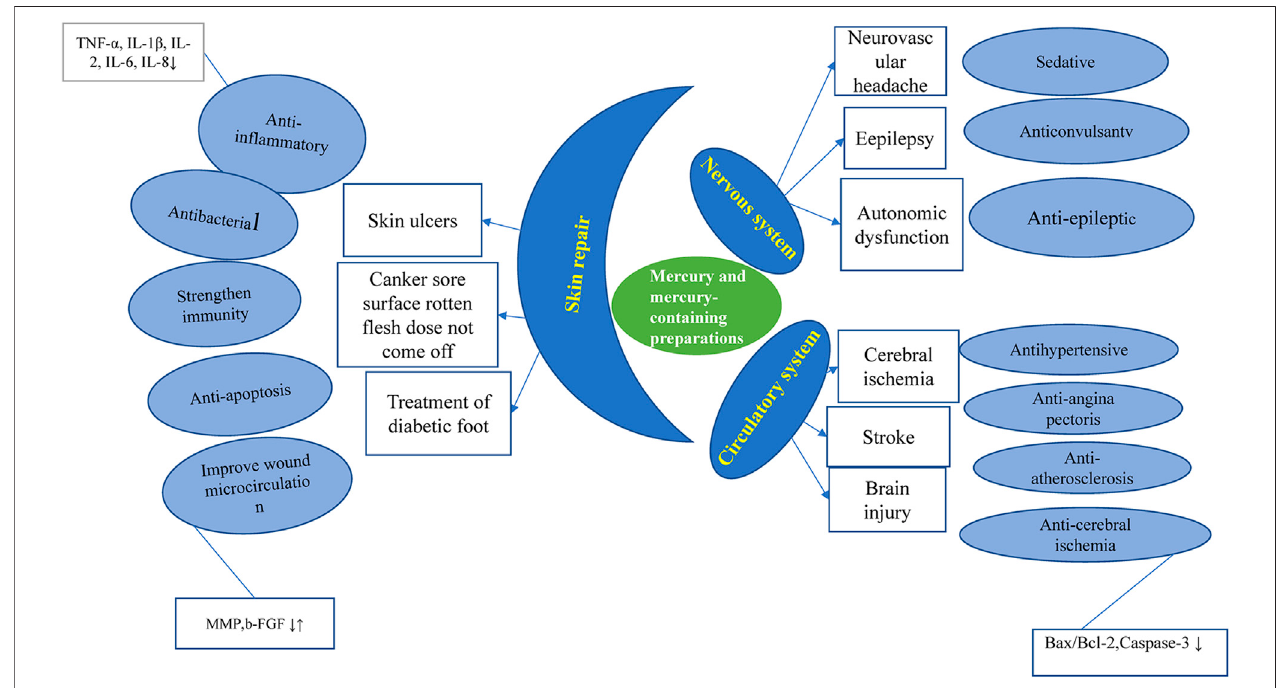
FIGURE 1 | Diseases and pharmacological effects of mercury and mercury-containing